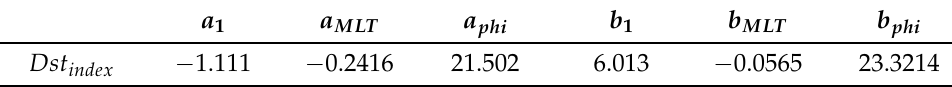
Table 1. Parameters used to estimate the plasmapause